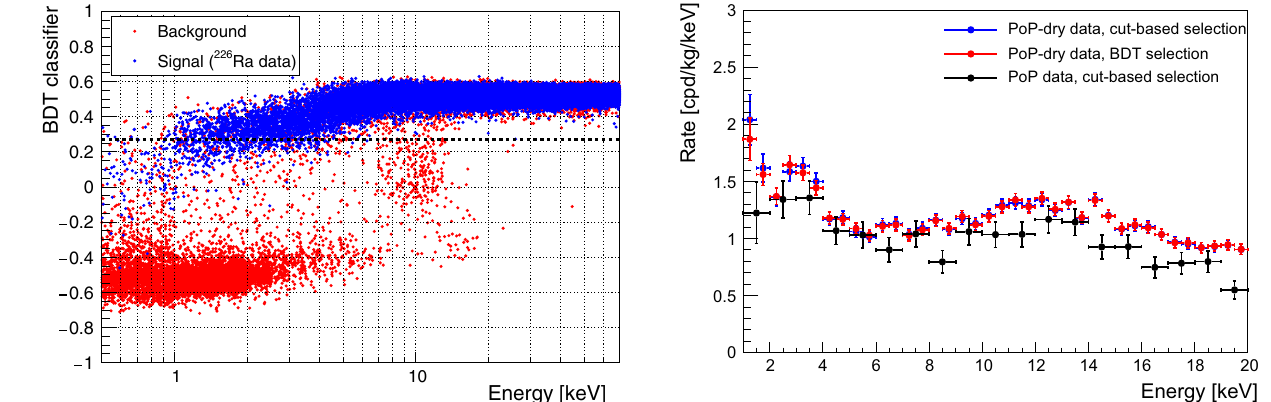
Fig. 8 NaI-33 low energy spectrum (after selection cuts and acceptance-correction) for data acquired with the PoP-dry (red points forBDTandbluepointforcut-basedselection)andthePoPsetup(black points). The latter includes only events in anti-coincidence with the liq- uidscintillatorveto.Thewiderbinning(anderrorbars)reflectsthe ∼ 10 times lower